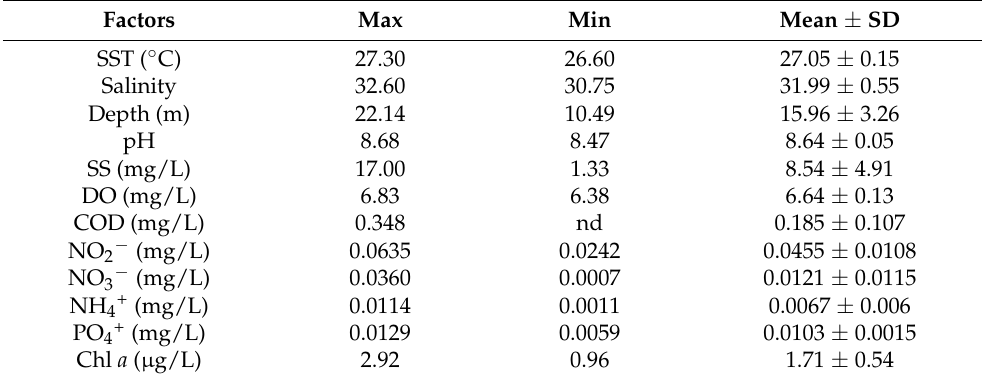
Table 5. Summary of data on environmental